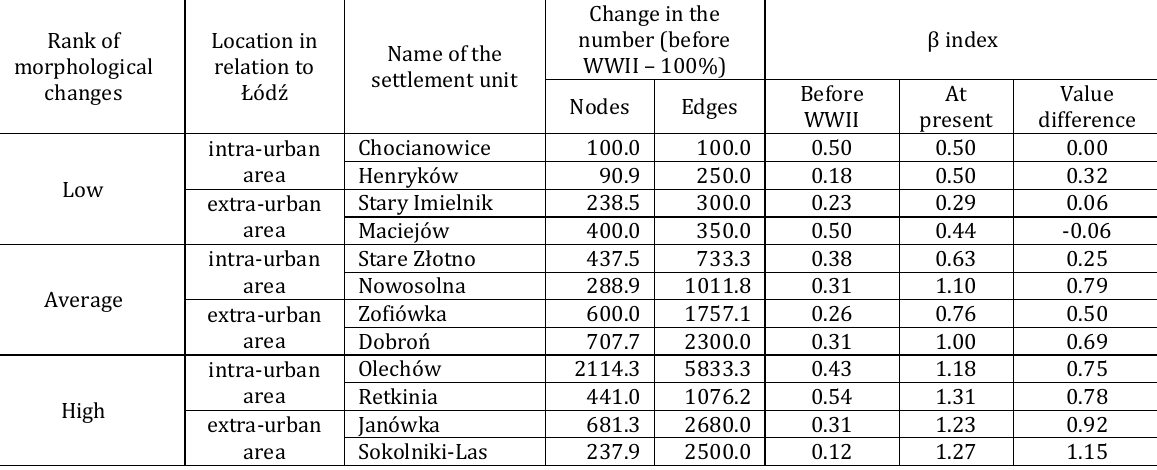
Table 2. Changes in the dynamics of the number of nodes and edges and the value of β index in the studied units in the inter-